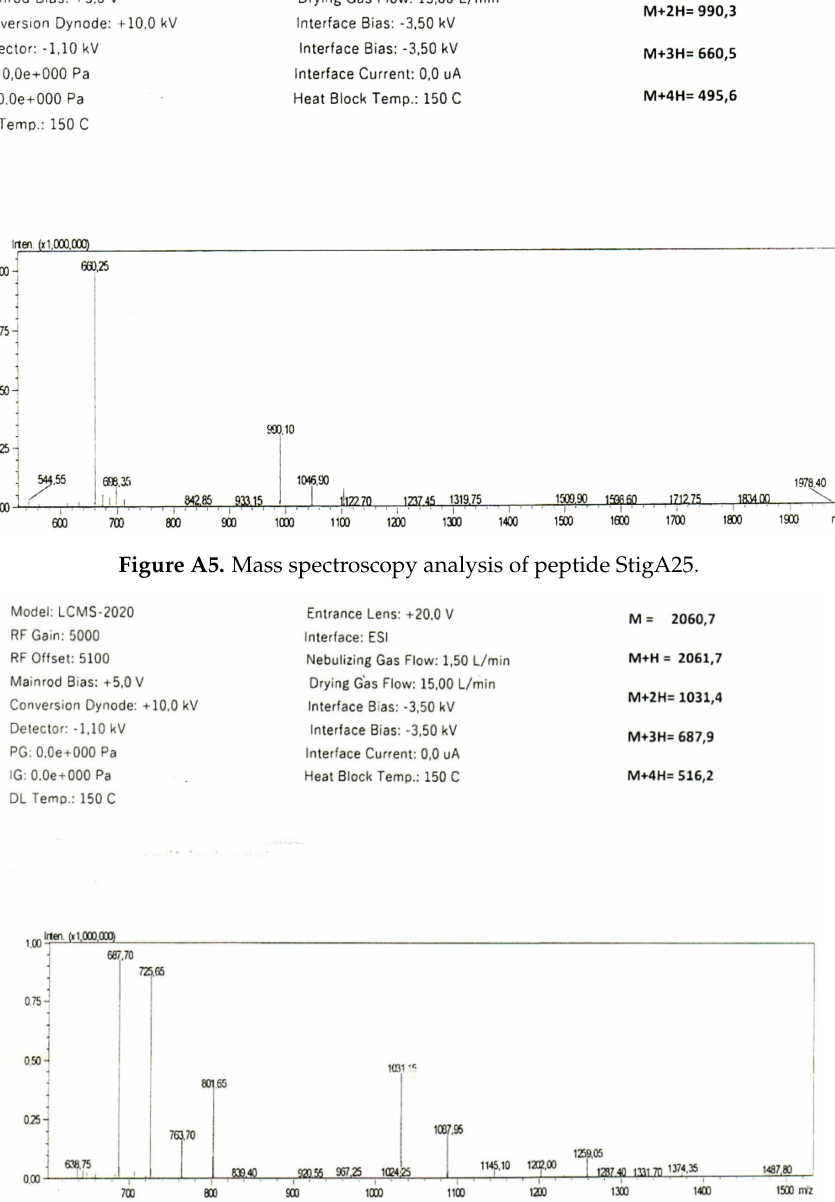
Figure A6. Mass spectroscopy analysis of peptide